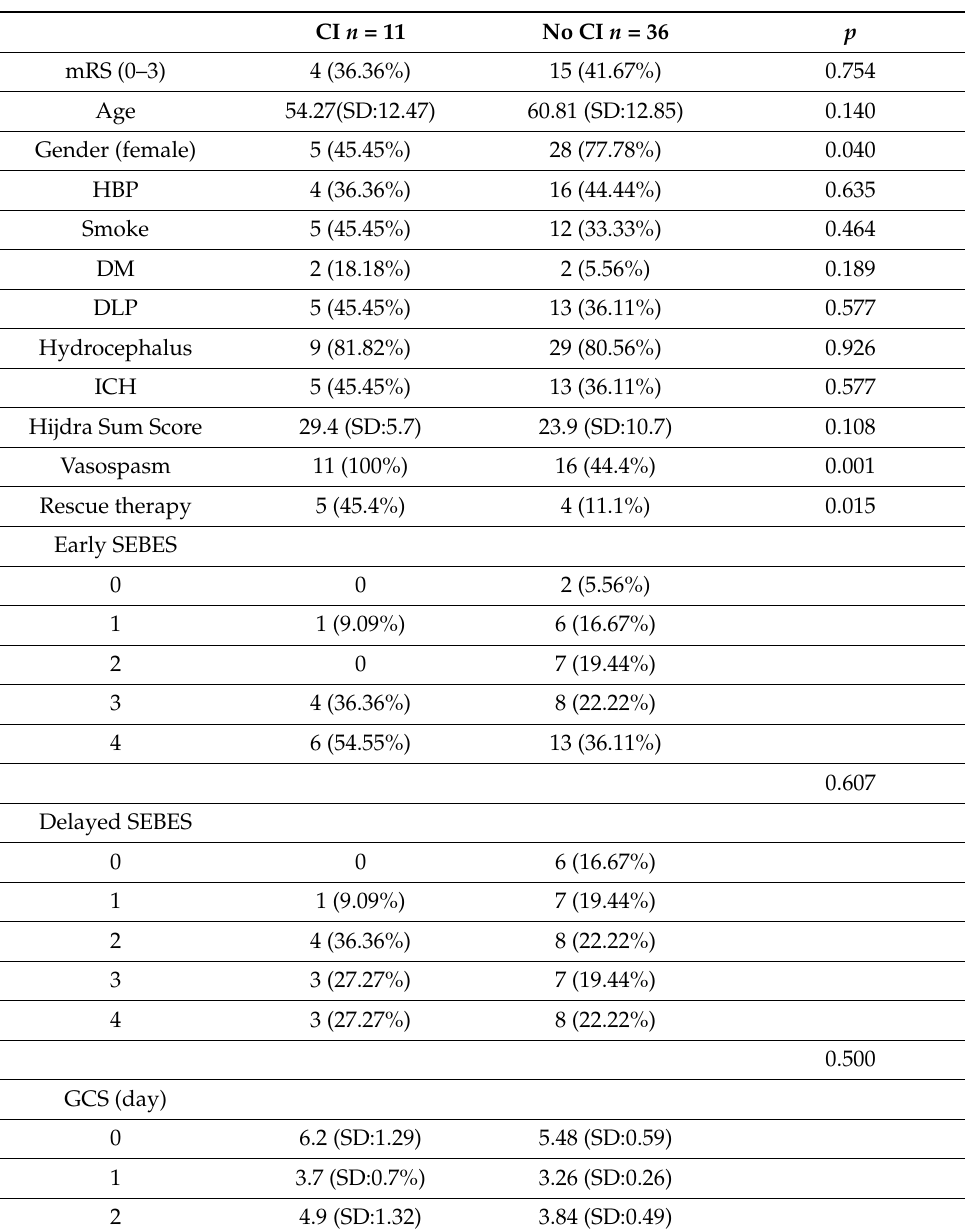
Table 1. Demographic of DCI (Delayed Cerebral Infarctions) risk factors of patients included in the